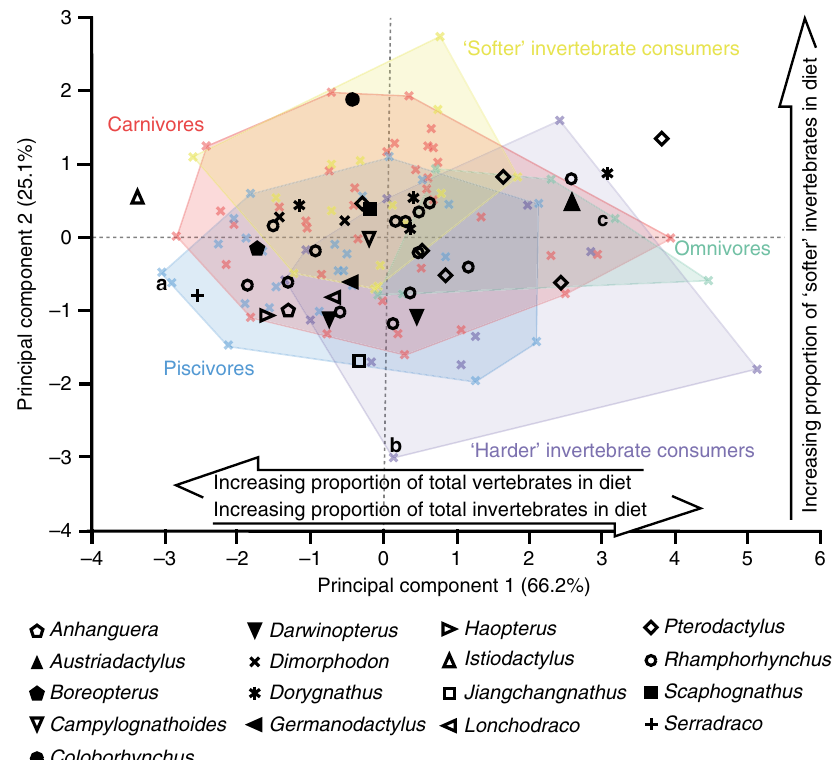
Fig. 2 Quantitative textural analysis of microwear in extant reptiles and pterosaurs. Texture-dietary space of International Organisation for Standardisation (ISO) texture parameters for reptiles and pterosaurs. Texture-dietary space based on extant reptile data ( n = 95) with pterosaurs ( n = 40) projected onto the fi rst two axes as unknown datum points. Extant specimens with associated letters represent surfaces a – c in Fig. 1. Arrows show signi fi cant correlations of dietary characteristics along PC axes 1 and 2. Pterosaur specimen information corresponding to PCA plot number can be found in Supplementary Fig. 2 and in Supplementary Data 1. Texture-dietary space adapted from Fig. 2 of ref. 18 (https://www.nature.com/articles/s41598-019- 48154-9/ fi gures/2) by Jordan Bestwick and Mark Purnell under a Creative Commons Attribution 4.0 International License https://creativecommons.org/ licenses/by/4.0/ to include the pterosaur